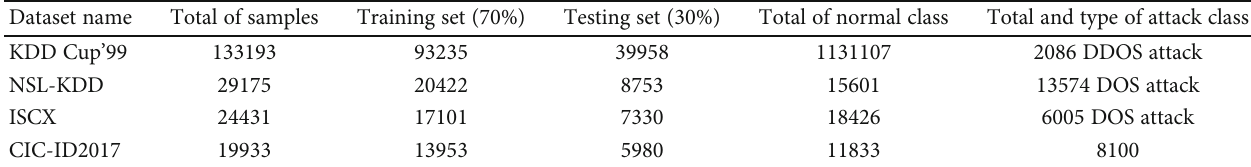
Figure 5: Performance of information gain method (a) KDD Cup ’ 99, (b) NSL-KDD, and (c) CIC-IDS 2017 datasets. Table 5: Distribution and splitting of the used